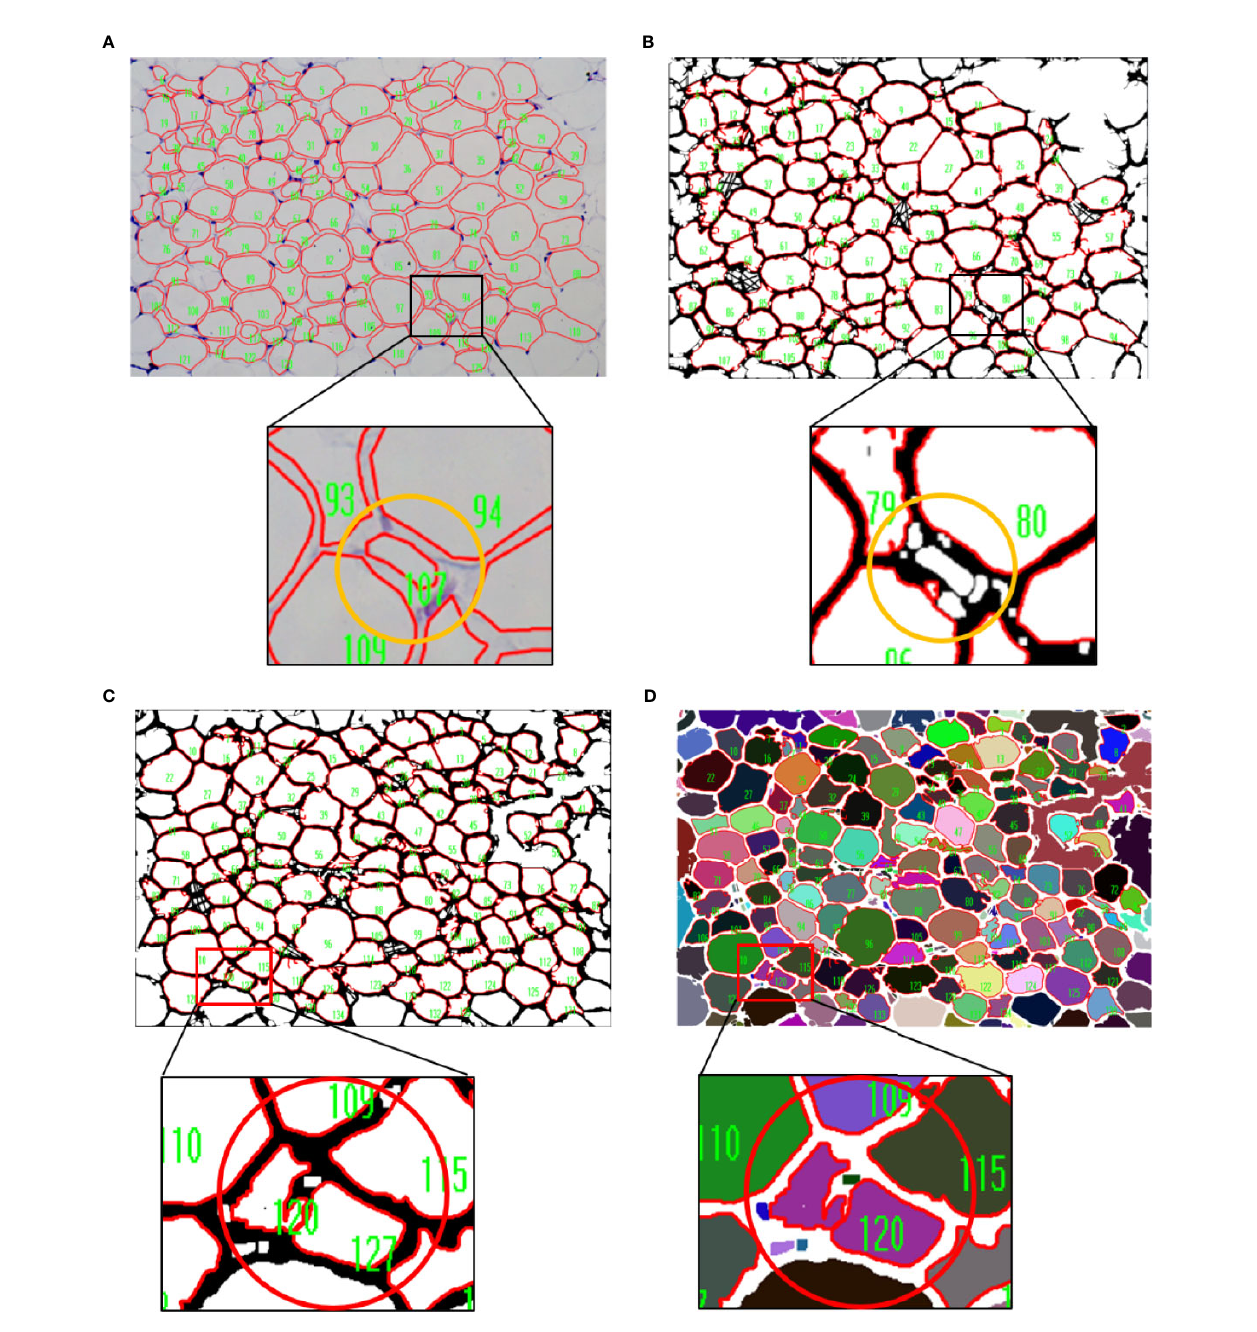
FIGURE 6 | Limitation of the combined measurement. (A, B) The results of manual and combined measurement. The cell numbered 107 in yellow circle was counted when using manual measurement (A) ,whereas it was excluded when the combined method was performed (B) . (C, D) Comparison of measurement results of two different segmentation images. Two cells inside the red circle could be distinguished in monochrome segmentation image (C) , but not in color segmentation image (D)